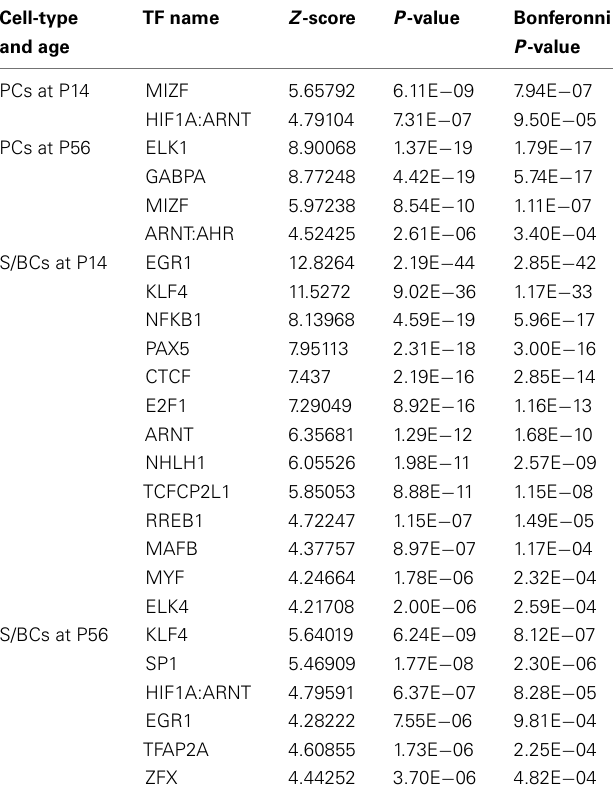
Table 1 | PSCAN results for PC and S/BC showingTF enriched among the co-expressed transcripts at P14 and P56 time